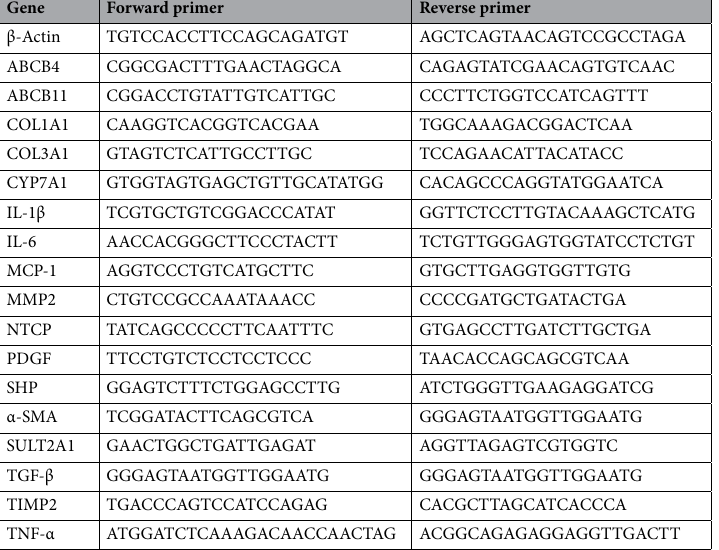
Table 1. Protein extraction and Western Blot analysis. The protein was extracted from the liver tissues using RIPA buffer (Beyotime, Shanghai, China) containing protease inhibitor, phosphatase inhibitor and Phenyl- methylsulfonyl fluoride (PMSF). 30 μg proteins were separated using sodium dodecyl sulfate polyacrylamide (SDS-PAGE) gel, and transferred to polyvinylidene fluoride (PVDF) membranes. Blocked in 5% BSA for 2 h at the room temperature, and incubated in primary antibody for α-SMA (cat. no. ab5694, Lot: GR3183259-37, Abcam, Cambridge, MA), COL1 (cat. no. ab34710, Abcam, Cambridge, MA), IκB α (cat. no. 4814; Cell Signal- ing Technology), p-IκB α (cat. no. 2859; Cell Signaling Technology), p65 (cat. no. 8242; Cell Signaling Technol- ogy), p-p65 (cat. no. 3033; Cell Signaling Technology), GAPDH and β-Actin (Huabio, Hangzhou, China), with 1:1000 dilution in 3% BSA at 4 °C overnight. Then, the membranes were washed three times with TBST each 10 min, and the membranes were incubated in the secondary antibody at room temperature for 2 h. The blots were visualized using ECL chemiluminescence kit (Beyotime, Shanghai, China). GAPDH was used as loading control and Image J software (National Institutes of Health, Bethesda, MD, USA) was used for densitometric analysis of the bands. Statistics analysis. Statistical analyses were performed using GraphPad Prism V.7.00 (La Jolla, CA, USA). All date were presented as means ± standard error of the mean (S.E.M). Comparisons were carried out via One- way analysis of variance (ANOVA) followed by Dunnett’s tests. Differences were considered statistically signifi- cant when p was < 0.05.